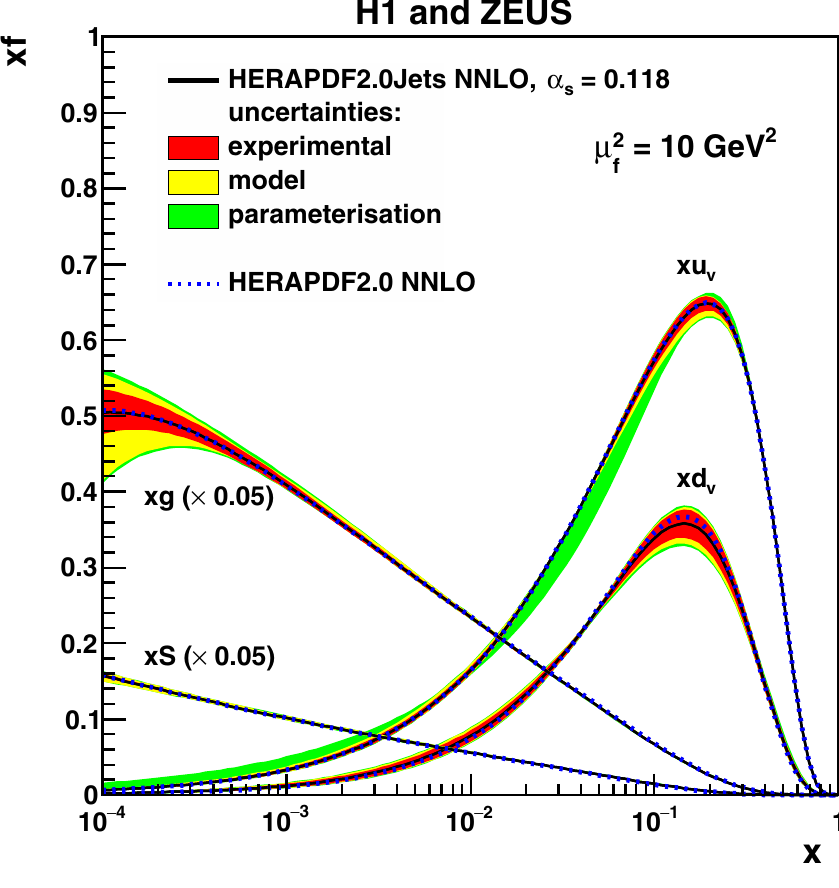
Fig. 7 Comparison of the parton distribution functions xu v , xd v , xg and xS = x ( ¯ U + ¯ D ) of HERAPDF2.0Jets NNLO with HERAPDF2.0 NNLO based on inclusive data only, both with ) = 0 . 118, at the fixed α s ( M 2 Z = 10GeV 2 . The scale μ 2 f uncertainties of HERAPDF2.0Jets NNLO are shown as differently shaded bands and the central value of HERAPDF2.0 NNLO is shown as a dotted